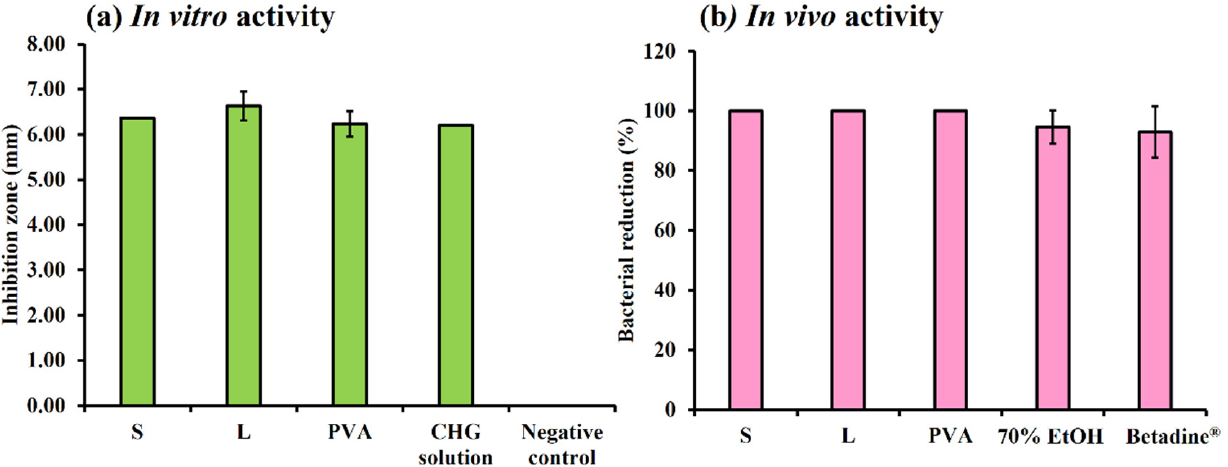
Figure 5. ( a ) In vitro and ( b ) in vivo antiseptic activity of the CHG-FFS. The experiments were repeated three times, and the results were presented as the mean ± SD.